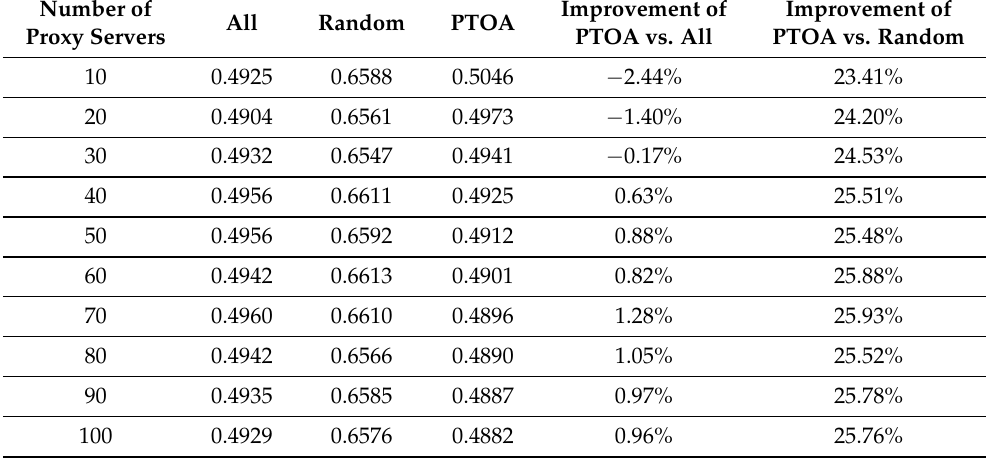
Table 5. Comparison of the average completion time of PTOA with the methods All and Random under a different number of proxy